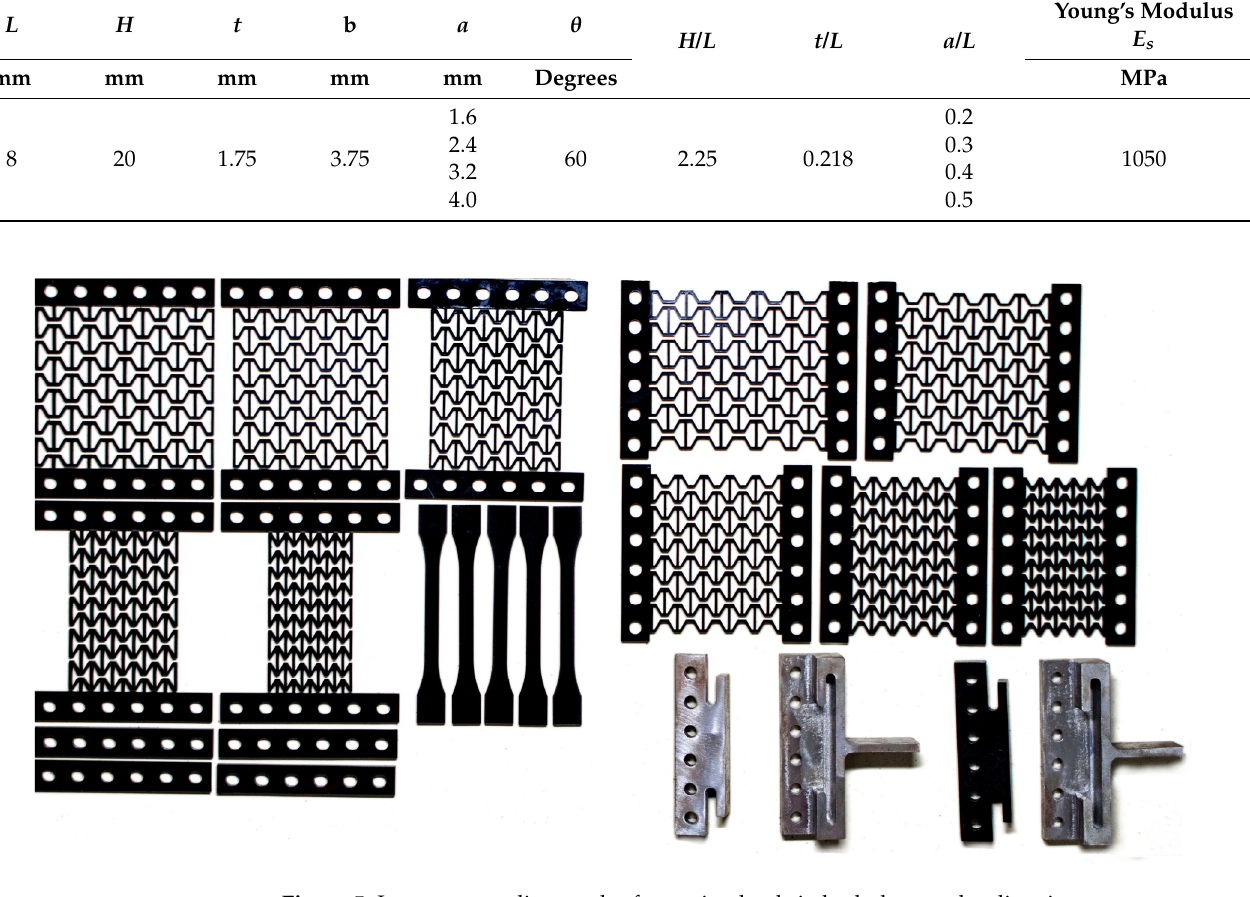
Figure 5. Laser-cut acrylic samples for testing loads in both the x and y-directions. Table 1. Dimensions of the test